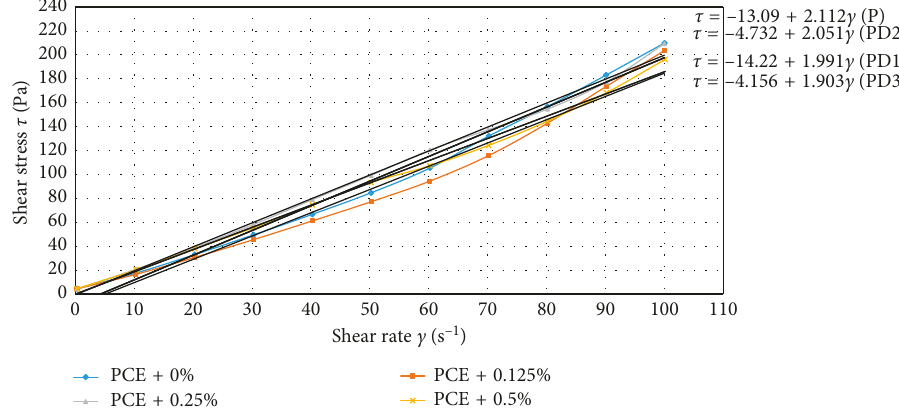
Figure 8: Flow curves of nanomodified cement pastes with PCE after 5min of mixing.